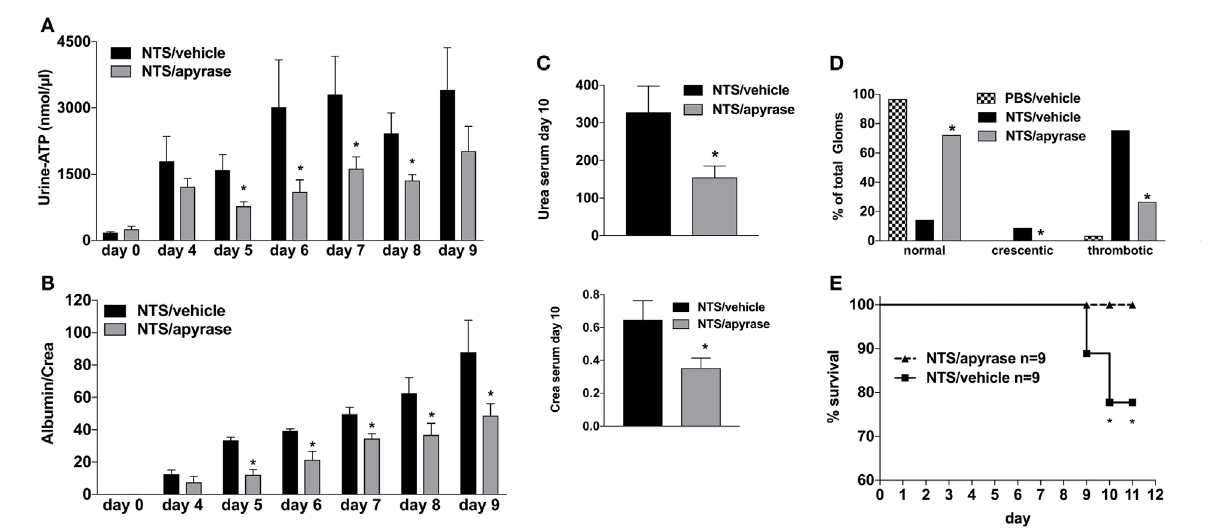
FigUre 2 | Effect of Apyrase treatment on nephrotoxic serum (NTS)-driven glomerulonephritis (GN). C57BL/6 mice received either vehicle (PBS) or (NTS solved in PBS) intravenous on days 1, 2, and 3 to induce GN. For treatment, they received i.p. injections of either vehicle or apyrase (4 U/ml in 100 µl) on days 1, 3, 5, 7, and 9. Urine was collected daily and analyzed for its adenosine-5’-triphosphate content (a) and its albumin–creatinine ratio (B) . Animals were killed on day 10 after a blood sample had been taken. This was analyzed for its serum urea and creatinine levels (c) . From the killed animals, kidney tissue was prepared and analyzed with microscopy (PAS-staining). Approximately 100 Glomerula in each sample were analyzed following the histological criteria “normal, crescentic, or thrombotic” (D) . Follow-up of mice receiving apyrase or vehicle are shown (e) . Data are shown as mean ± SEM, n = 4–5 mice in each group. * P < 0.05 . Data from one representative experiment out of three are